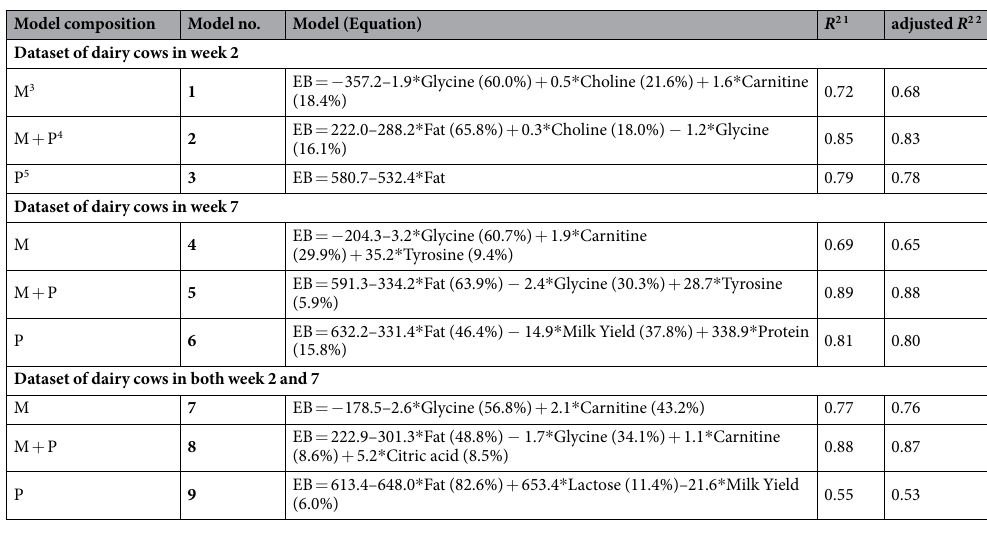
Table 3. Reduced models to estimate the energy balance of dairy cows in lactation week 2 and 7. The reduced models were selected by multivariate linear regression. The models were built by the concentrations of the milk metabolites and milk production treats. 1 R 2 was obtained through 10-fold cross-validation. 2 adjusted R 2 considered the number of independent regressors in a model, and it was obtained through formula, adjusted R 2 = 1 − [(1 − R 2 ) (n − 1)/(n − k − 1)], n is the number of sample size, k is the number of independent regressors, excluding the constant. 3 M: only milk metabolites are used in the model. 4 M + P: both milk metabolites and milk production traits are used in the model. 5 P: only milk production traits are used in the